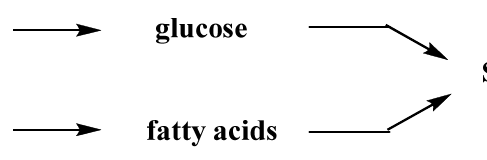
Figure 4. Metabolic Sources of S-Acetyl CoA.